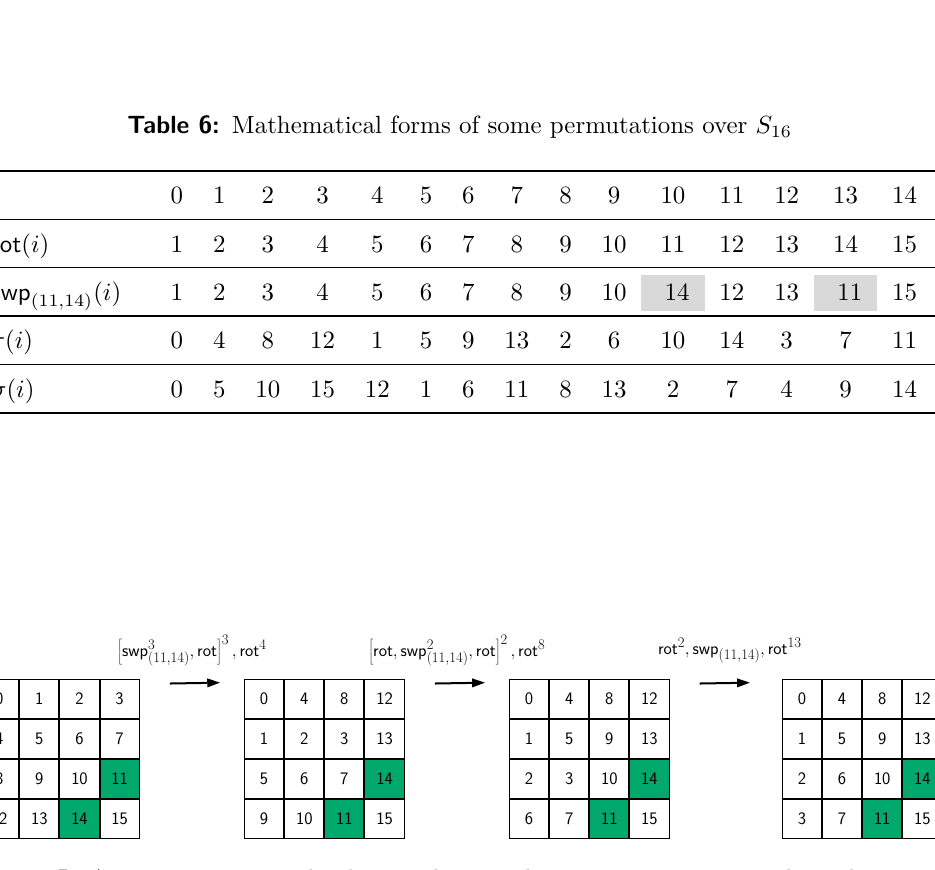
Figure 5: A transposition can be done with rot and swp in 3 × 16 cycles. The opera- (11 , 14) tions separated by comma are executed in leftmost-first fashion. The cells corresponding to fixed swap positions of swp are marked with green. (11 , 14)